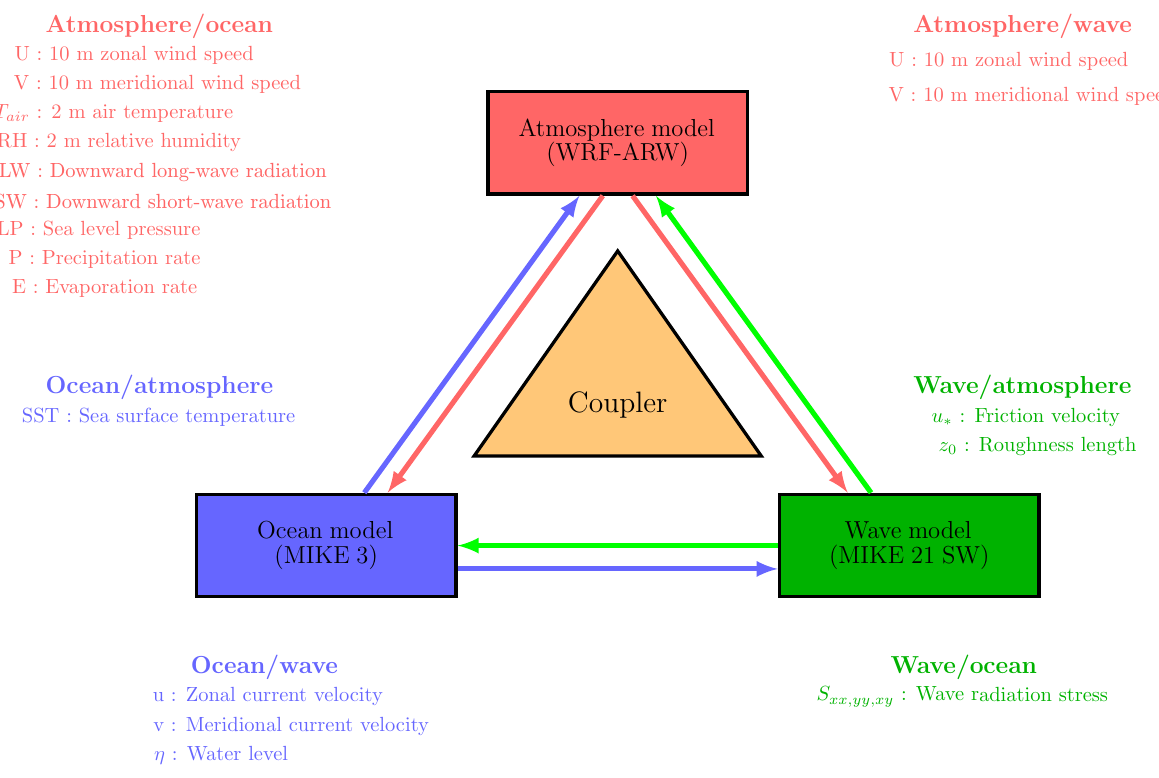
Figure 5. Schematics of coupled model components, where the atmosphere model (WRF), ocean model (MIKE 3) and wave model (MIKE 21 SW) interact through model coupling